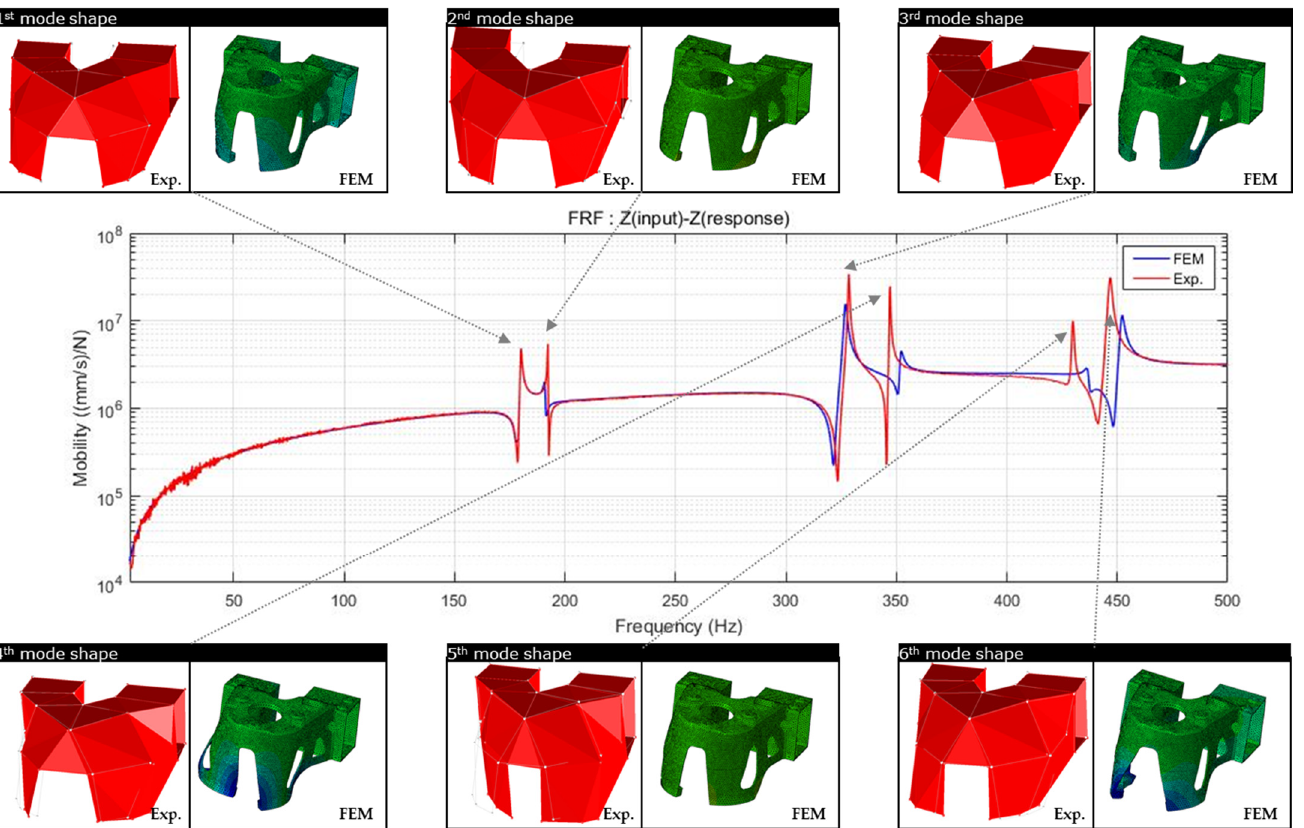
Figure 16. Comparison of natural frequency and mode shape of modal analysis using finite elements and experiment.